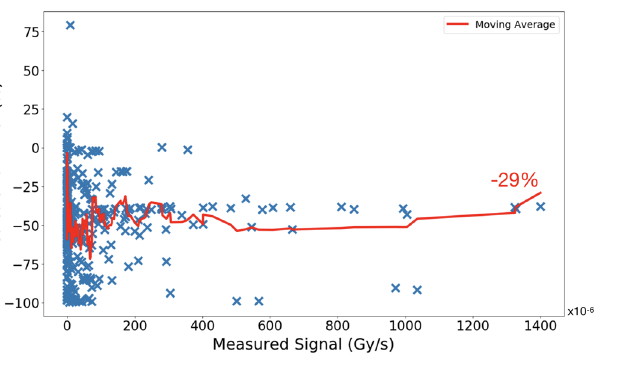
FIG. 12. Scatter plot of the loss map measured signal points above 10 − 7 Gy = s, against the calculation error, for the two skew collimators. The moving average was calculated, showing the average error is mostly around − 50% for low BLM signals and − 30% for high BLM signals.